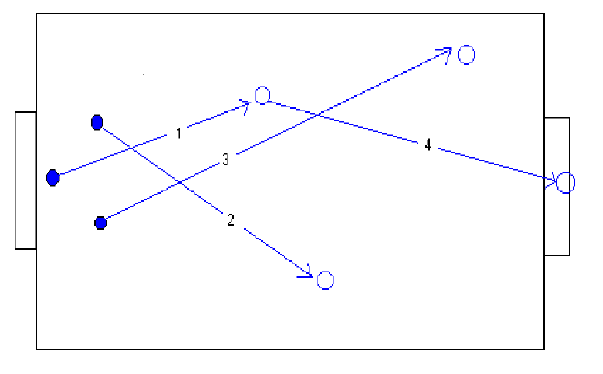
Figura 2. Representação da movimentação das tampinhas.